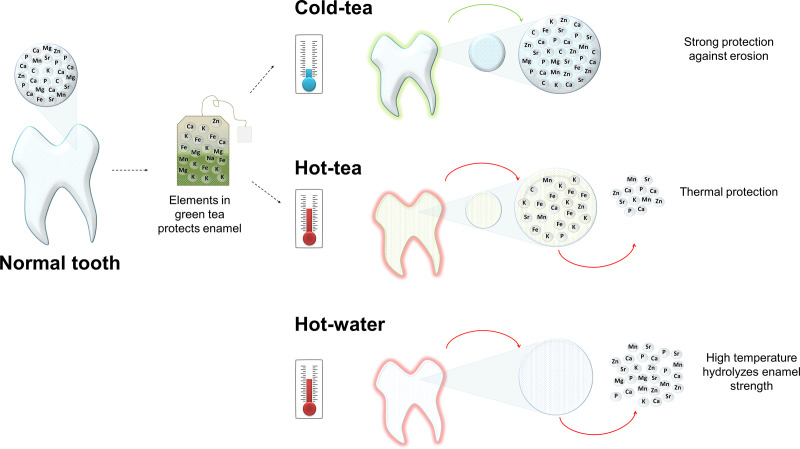
Schematic model illustrating the effect of tea and temperature on enamel.Healthy tooth showing a representation of the principal elements in the mineral phase (insert). There is a direct interaction between elements in teeth with the elements in tea, represented by the arrow directed toward the teabag. Cold tea favors enamel absorbing tea elements providing structural protection; although, metals pigment the enamel surface (green on the tooth). Hot tea protects against temperature although deposition of metal stains the surface. The high temperature of hot water results in the loss of elements forming the inorganic matrix.